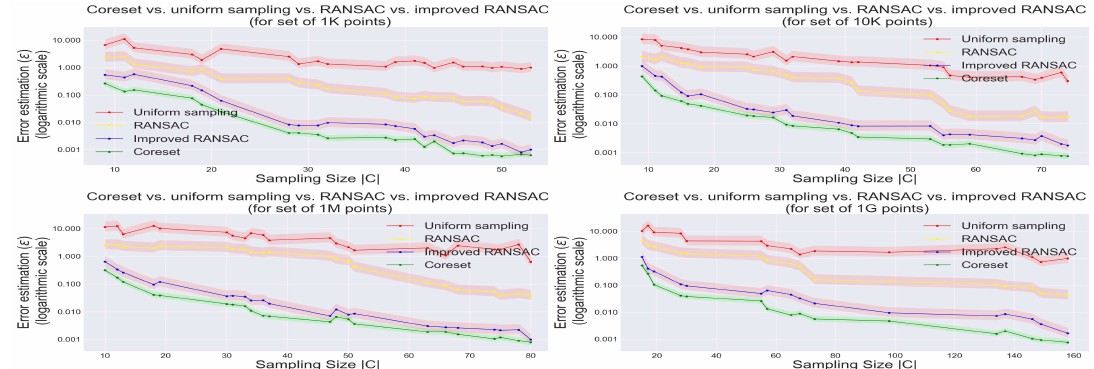
Figure 5. The 3D experiments result. The following four graphs show comparison results between coreset sampling by our algorithm with uniform sampling and the same amount of sample data, compared to the RANSAC algorithm (on the full set and on the coreset) that runs at the same time. Each graph displays results for a differently-sized data